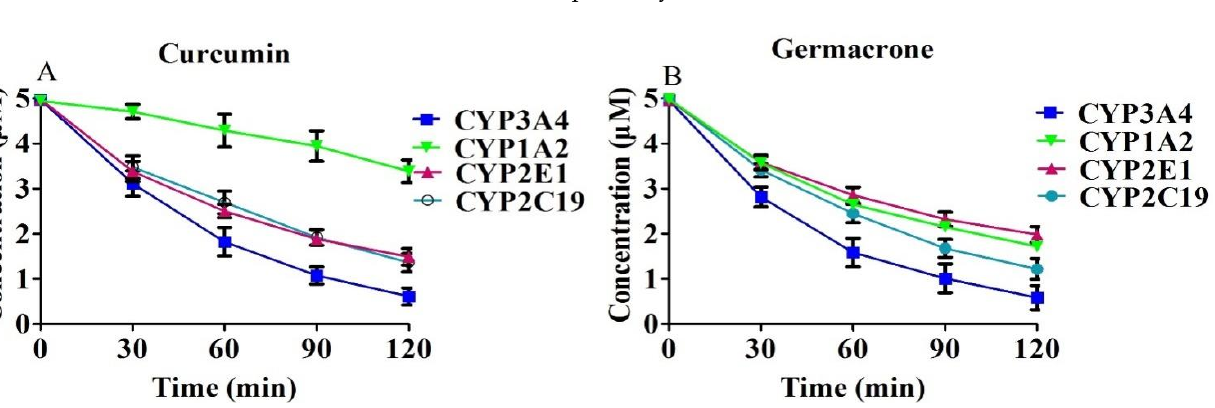
Figure 5. Degradation of curcumin ( A ), 5 μM and germacrone ( B ), 5 μM in CYP3A4, 1A2, 2E1 and 2C19 in vitro ( n = 3).